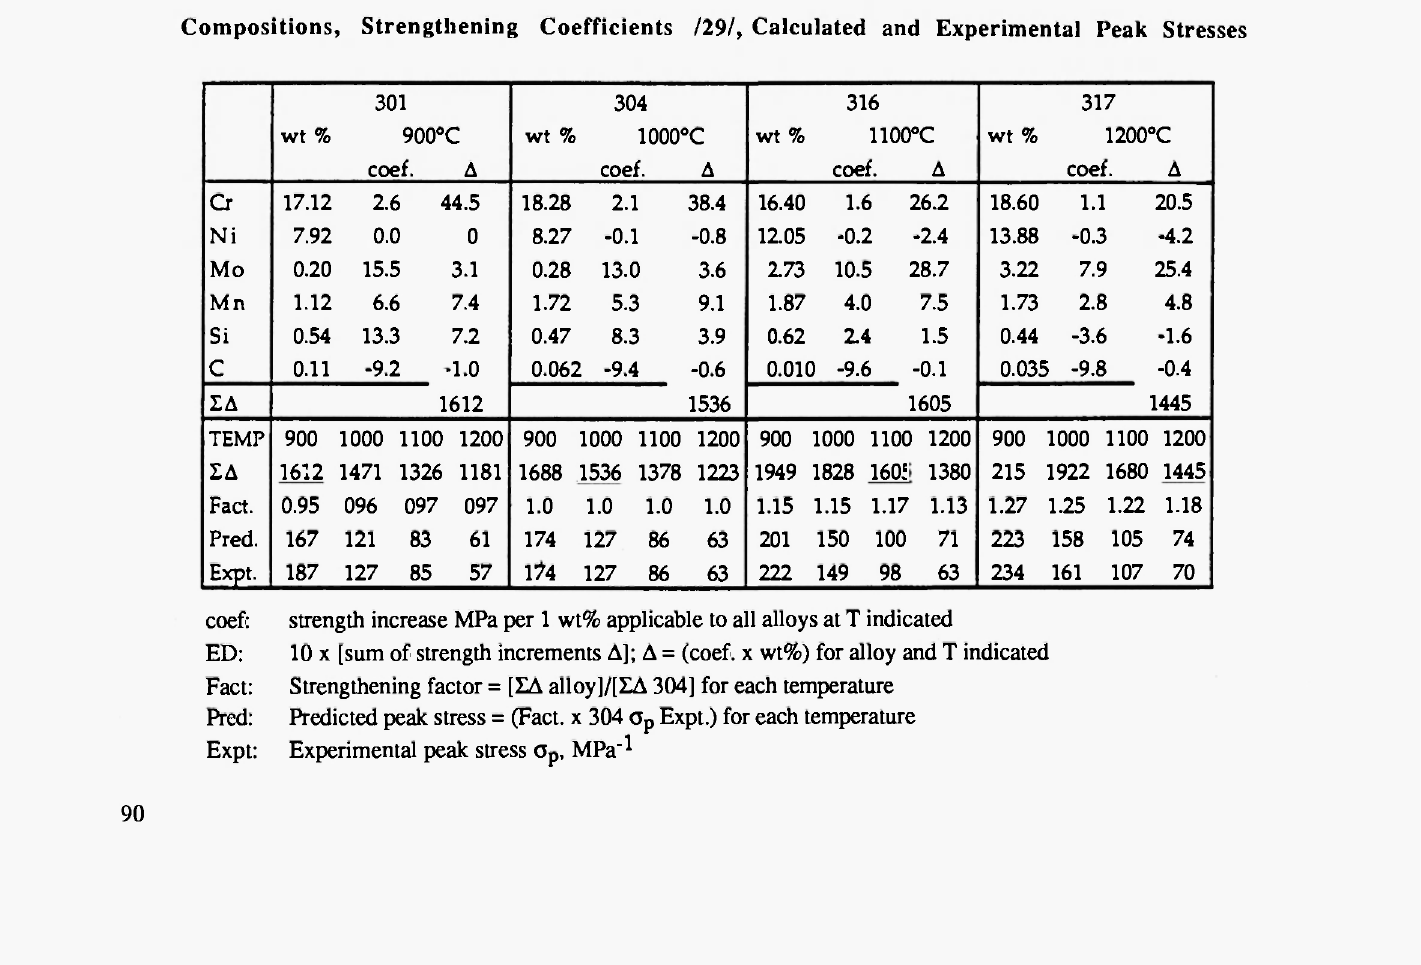
The peak stress is plotted against log (% MS) in (a) and log (% Mo) in